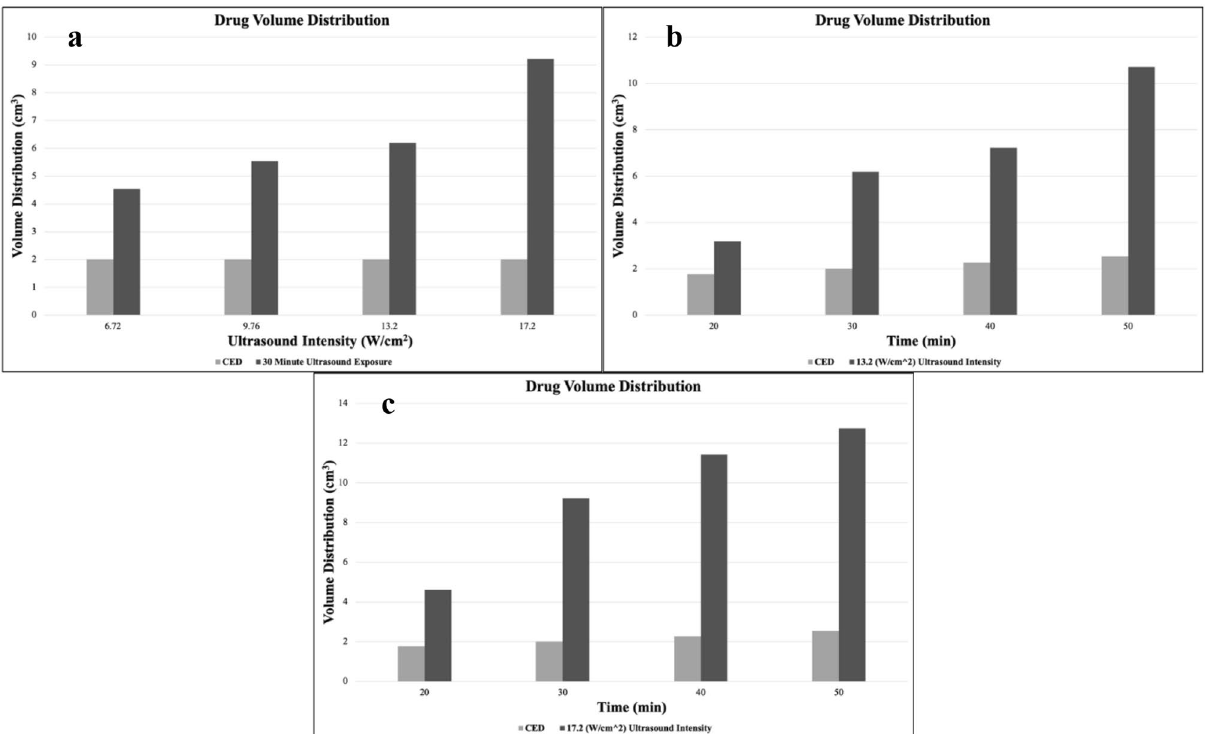
Figure 6. Variations of drug volume distributions for the three experiments: ( a ) shows the values for Experiment I (dark gray data) and CED samples (light gray data) for 30 min of ultrasound exposure at different ultrasound intensities. ( b ) shows the increase in drug volume distribution over time for Experiment II (dark gray data) at an intensity value of 13.2 W/cm 2 , compared with CED results (light gray data) ( c ) indicates the comparison between the drug volume distributions calculated from the data of Experiment III (dark gray data) and from CED samples (light gray data) with different exposure times at an intensity value of 17.2 W/cm 2